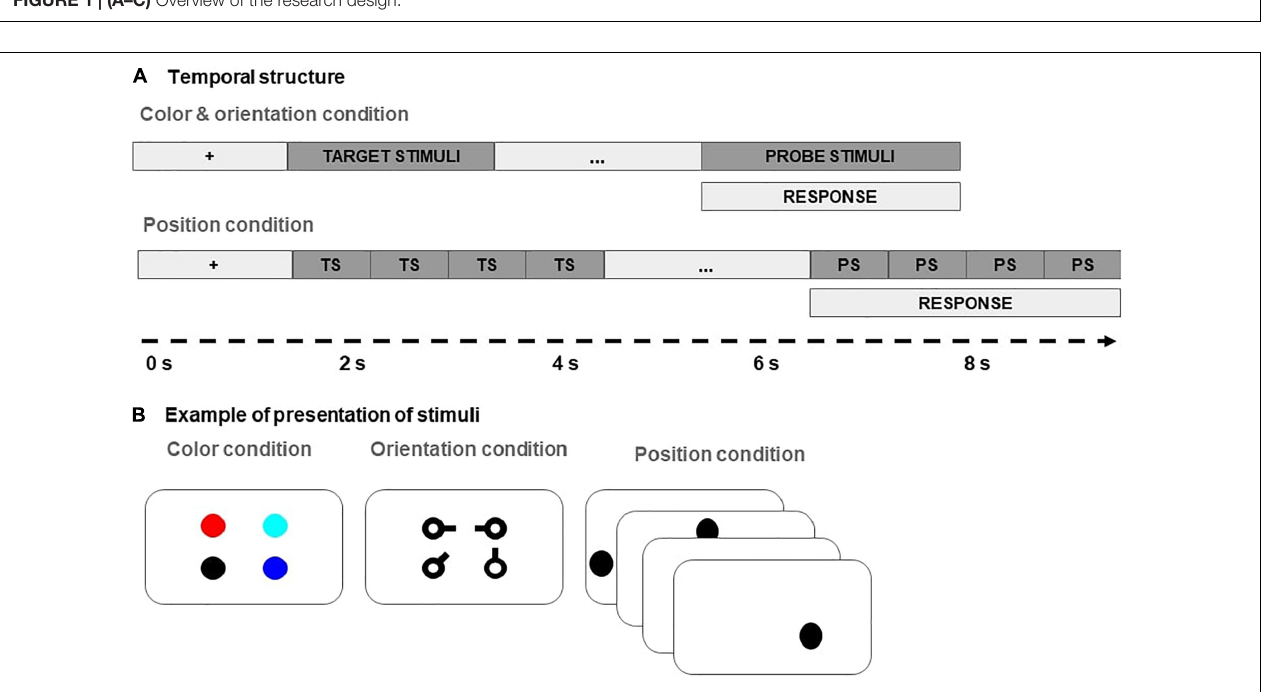
FIGURE 2 | (A) Timing structure; (B) stimuli of the